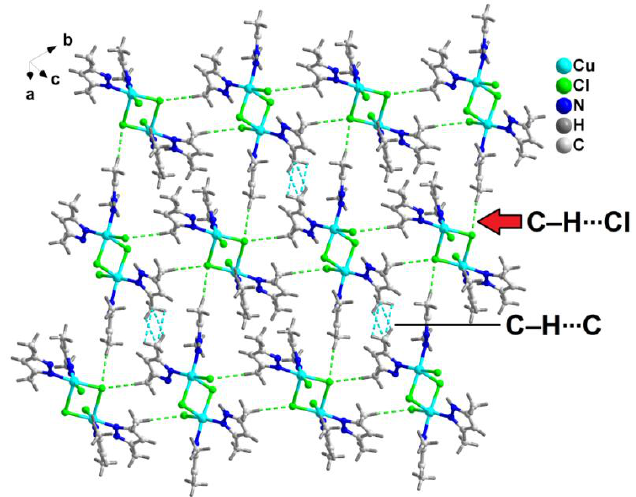
Figure 5. Layered assembly of compound 2 along the crystallographic ab plane, as assisted by the C–H ··· Cl hydrogen-bonding and non-covalent C–H ··· C Table 3. Selected hydrogen bond distances (Å) and angles (°) for compounds 1 and 2 .